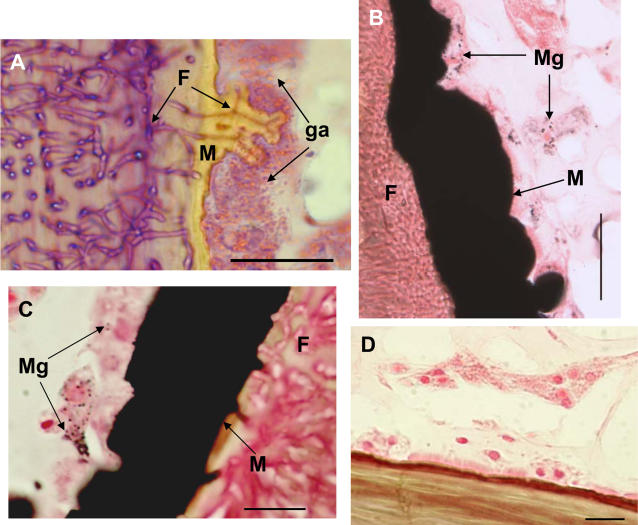
Histological images of sea fans infected with Aspergillus sydowii and presence of melanin both as a band and in amoebocytes as melanosomes.A) Histological preparation of an infected coral stained with H&E showing individual fungal hyphae (F) in skeleton and surrounded by melanin (M). Note granular amoebocytes (ga) aggregated near melanin and fungal hyphae. Scale bar = 25 µm. B) Histological preparation of an infected coral showing multiple amoebocytes containing melanin granules in contact with the thick layer of melanin preventing A. sydowii hyphae within the axial skeleton (at left) from contacting the sea fan tissue (on right). Fontana-Masson staining procedure, scale bar = 25 µm. C) Close up of an amoebocyte containing melanin granules (Mg) and black stained melanin (M) layer surrounding fungus (F). Fontana-Masson staining procedure, scale bar = 10 µm D) Uninfected coral stained with Fontana-Masson's procedure showing lack of melanin and melanin granules. Scale bar = 10 µm.